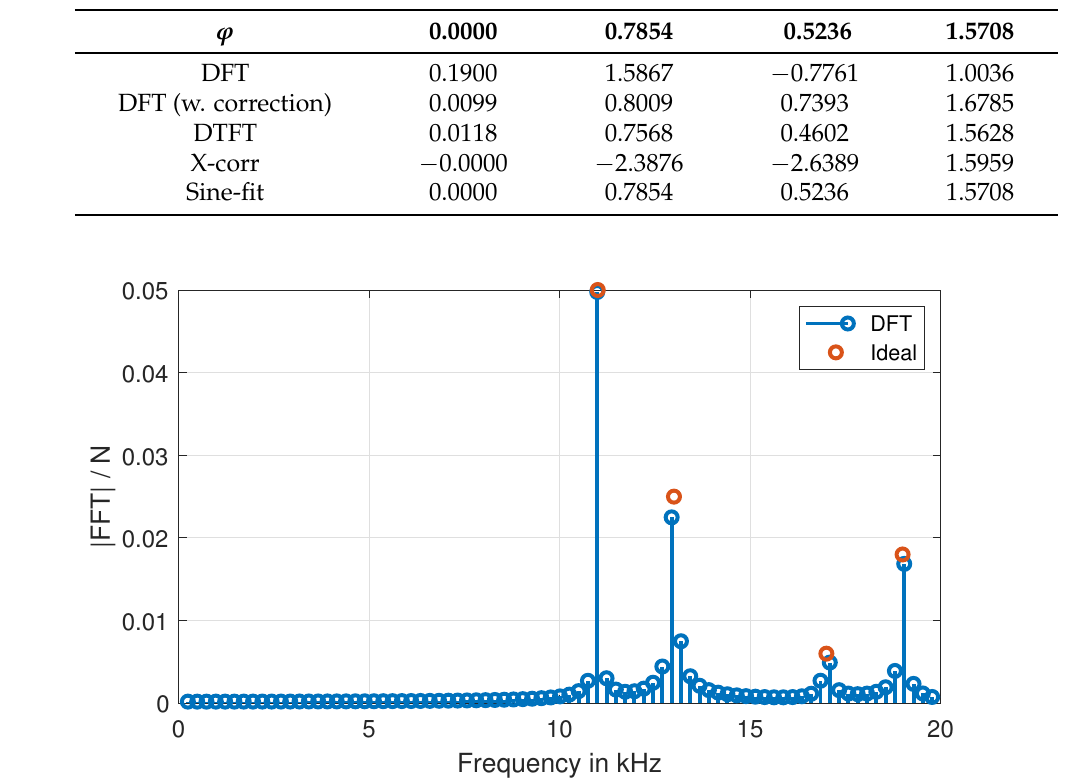
Figure 7. Amplitude spectrum using DFT on the test